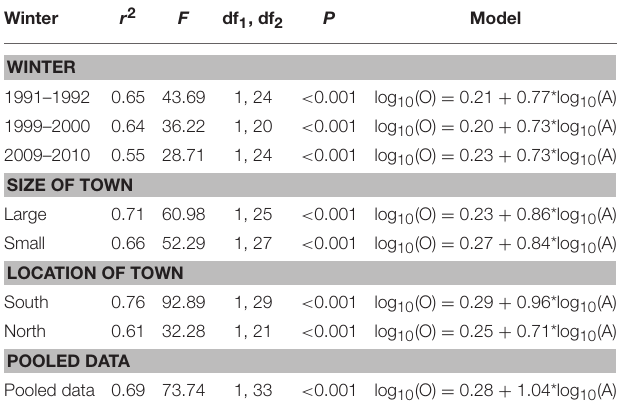
TABLE 3 | Relationship between regional occupancy (dependent variable, log 10 transformed) and mean local abundance (independent variable, log 10 transformed) of wintering birds in three study winters, different sizes of towns, and location of town and in pooled data in